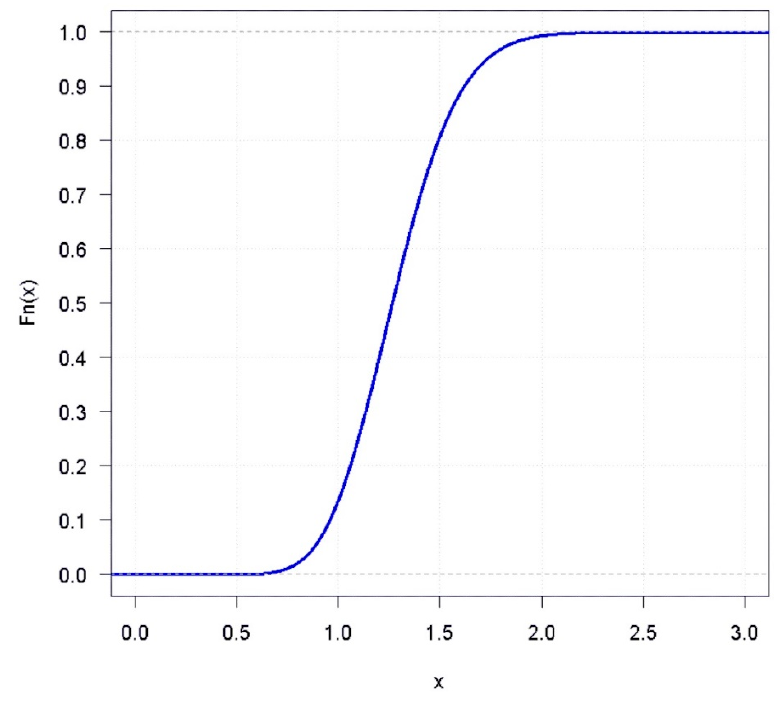
Figure 3. Empirical cumulative distribution.